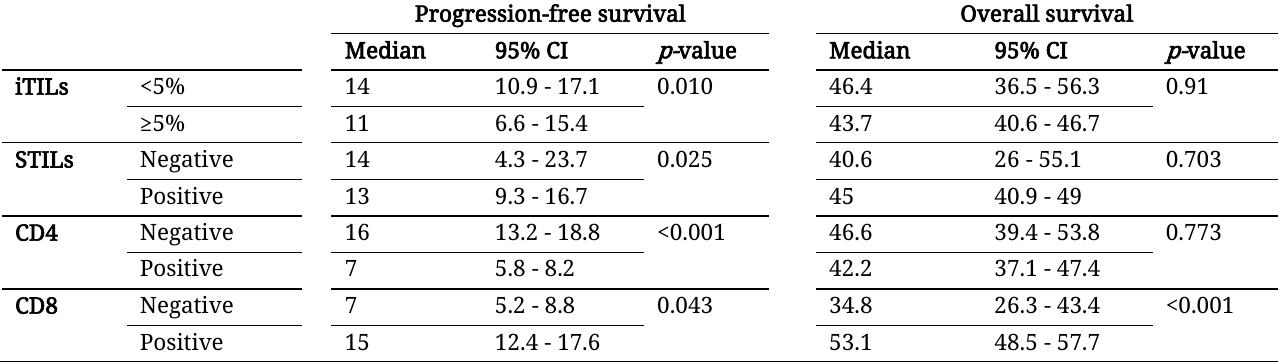
Figure 1: Examples of staining for intratumoral tumor-infiltrating lymphocytes (iTILs) and stromal TILs (sTILs): a) Invasive ductal carcinoma (IDC) with 60% iTILs and 40% sTILs (H&E 200X), b) IDC with <10% iTILs and 50% sTILs (H&E 200X), c) IDC with 30% iTILs and 50% sTILs (H&E 200X), d) All infiltrating lymphocytes are positive for CD8 (CD8 immunostaining, 200X), e) <10% of lymphocytes positive for CD4 (CD4 immunostaining, 200X), f) All infiltrating lymphocytes are negative for CD4 (CD4 immunostaining, 200X) Table 2: Overall and progression-free survival following 1 st line treatment according to iTILs, sTILs, CD4, and